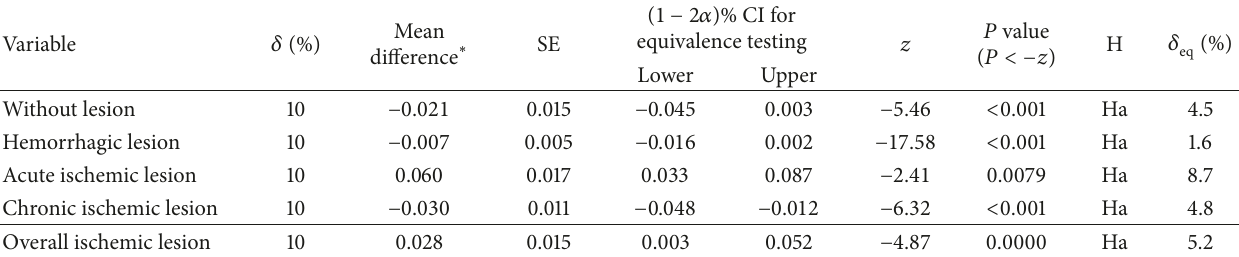
Table 2: Equivalence tests for the distribution on the type of stroke classification between reading systems.